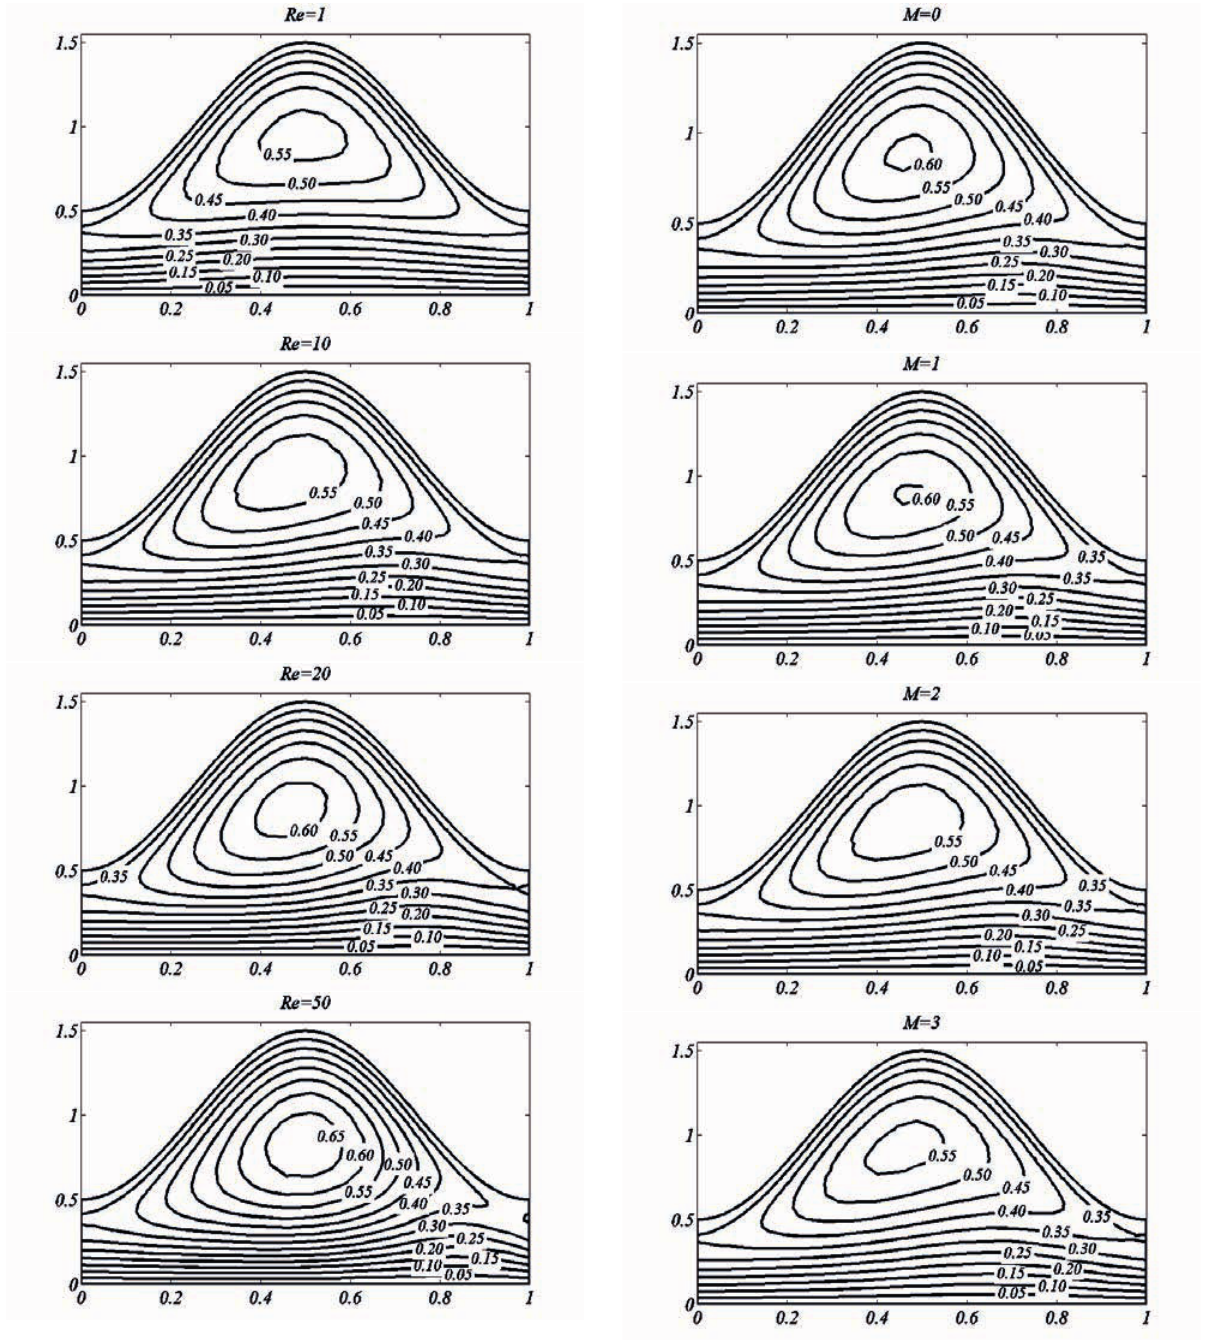
Fig. 9: Variation of streamlines against different values of Re in wave frame with β = 0.3, M = 2, α = 0.2, φ = 0.5, Q = 1.3 . Fig. 10: Variation of streamlines against different values of M in wave frame with Re = 10, β = 0.3, α = 0.2, φ = 0.5, Q = 1.3 .